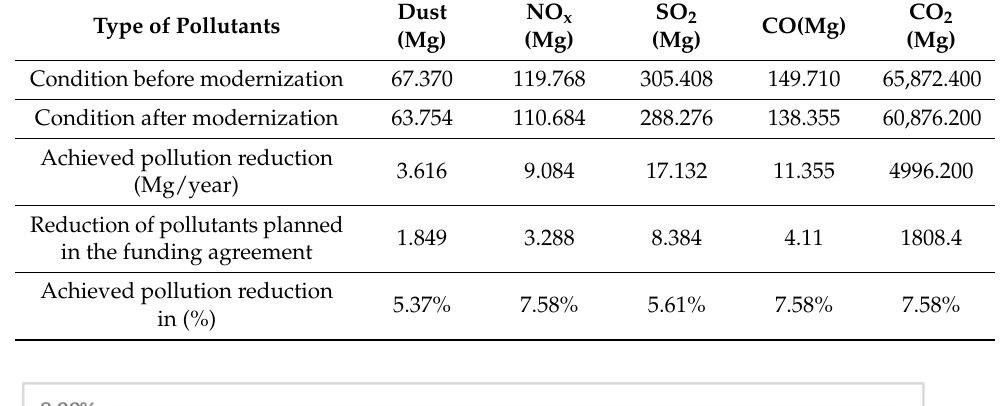
Table 2. Reduction in pollutants achieved by modernization of WR type boiler.